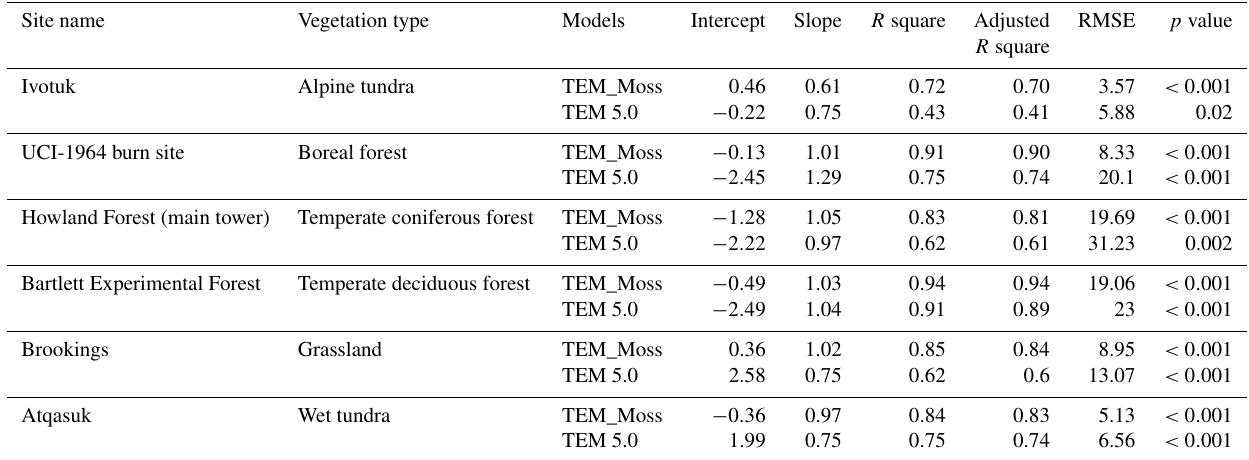
Figure 6. Comparison between observed and simulated NEP (gCm − 2 month − 1 ) at (a) Ivotuk (alpine tundra), (b) UCI-1964 burn site (boreal forest), (c) Howland Forest (temperate coniferous forest), (d) Bartlett Experimental Forest (temperate deciduous forest), (e) Brookings (grassland), and (f) Atqasuk (wet tundra). Table 6. Model validation statistics for TEM_Moss and TEM 5.0 at six sites with NEP